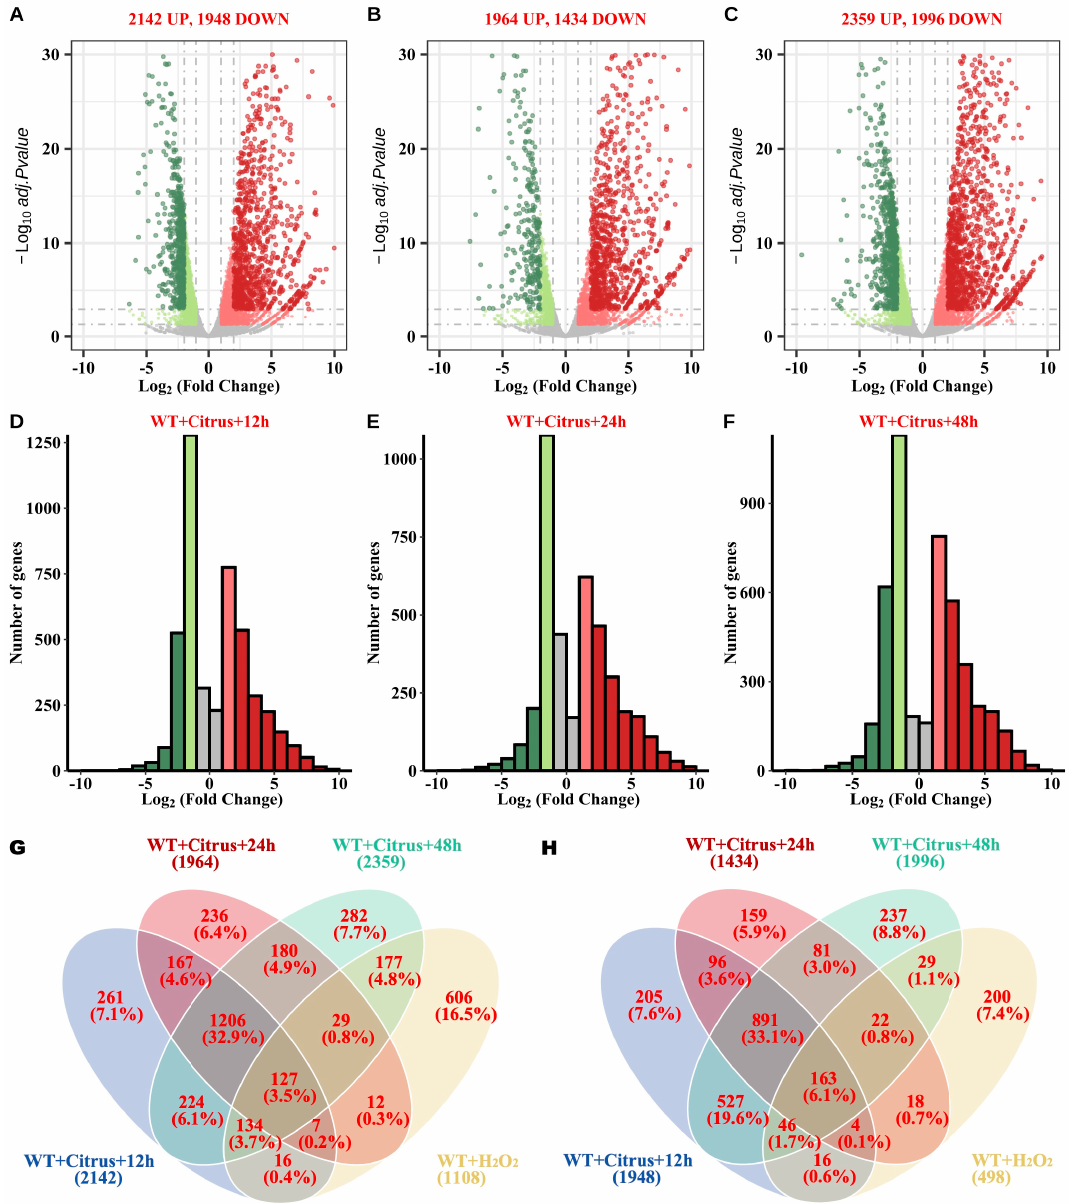
Figure 3. The global gene expression pattern of Alternaria alternata Z7 during infection in tran- scriptome profiles is studied. ( A – F ) The gene expression pattern of A. alternata during infection. ( A – C ) Volcano plots of the gene expression pattern of A. alternata. inoculated on citrus leaves at 12-, 24-, and 48 h post-inoculation (dpi). The y-axis of the volcano plots corresponds to the mean expression value of log10 [adjust p-value, also known as false discovery rate (FDR)], and the x-axis displays the log2(fold change value). The red dots represent the significantly differentially expressed transcripts [false discovery rate (FDR) <0.05] up-regulated under the indicated treatments compared to A. alternata Z7. The green dots symbolize the significantly differentially expressed transcripts (FDR < 0.05) down-regulated under the indicated treatments compared to A. alternata Z7. The grey dots show the transcripts whose expression levels did not reach statistical significance (FDR > 0.05) or the absolute value of log2(fold change value) was smaller than 1. ( D – F ) Histogram plots of the gene expression pattern of A. alternata Z7 inoculated on citrus leaves at 12-, 24-, and 48 h post-inoculation (dpi). ( G ) Venn diagram describing the overlaps among up-regulated genes in A. alternata Z7 inocu- lated on citrus leaves and treated with H 2 O 2 , while ( H ) is a Venn diagram illustrating the overlaps among down-regulated genes in A. alternata Z7 inoculated on citrus leaves and treated with H 2 O 2